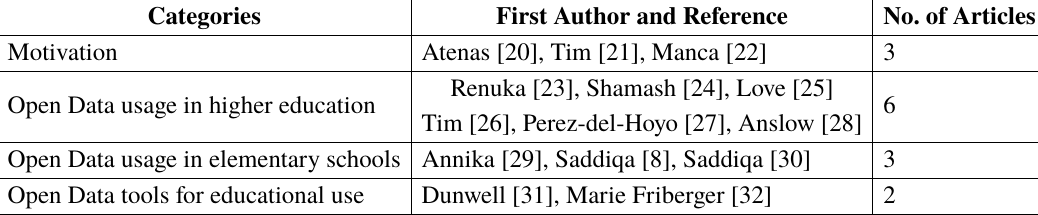
Table 2. Outline of reviewed articles and identified